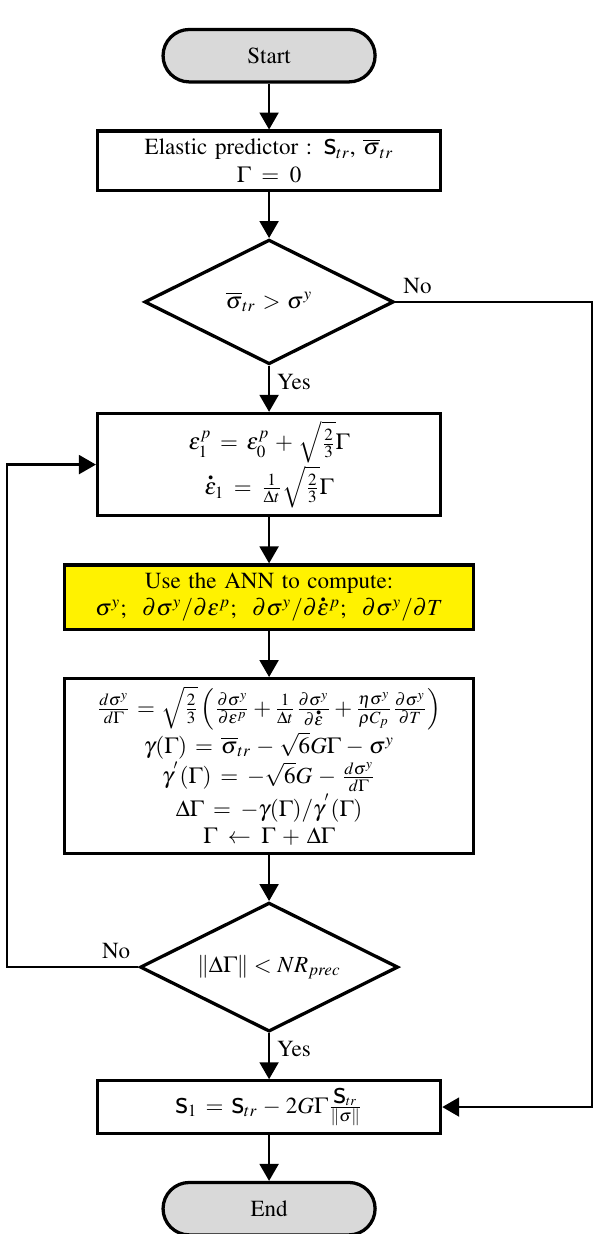
Figure 7. General flowchart of the radial return algorithm to compute the final stress tensor σ 1